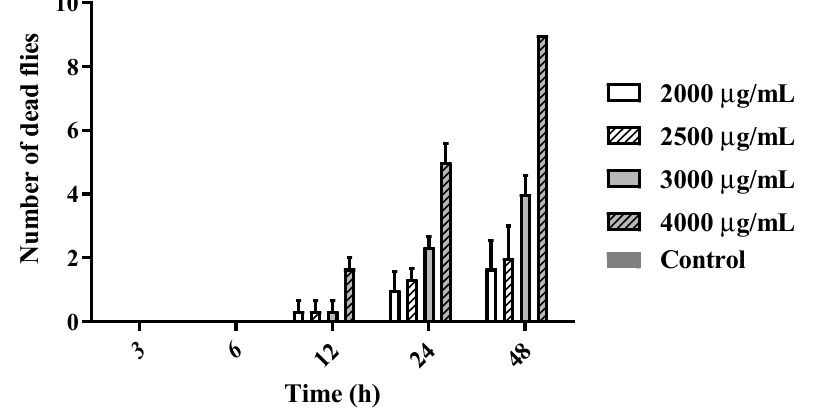
Figure 2. L. sidoides aqueous extract mortality tests against Drosophila melanogaster. The graph shows the mortality of D. melanogaster when exposed to concentrations of 2000, 2500, 3000, as well as 4000 μL/mL of the extract at 48 h of exposure compared to the control group.